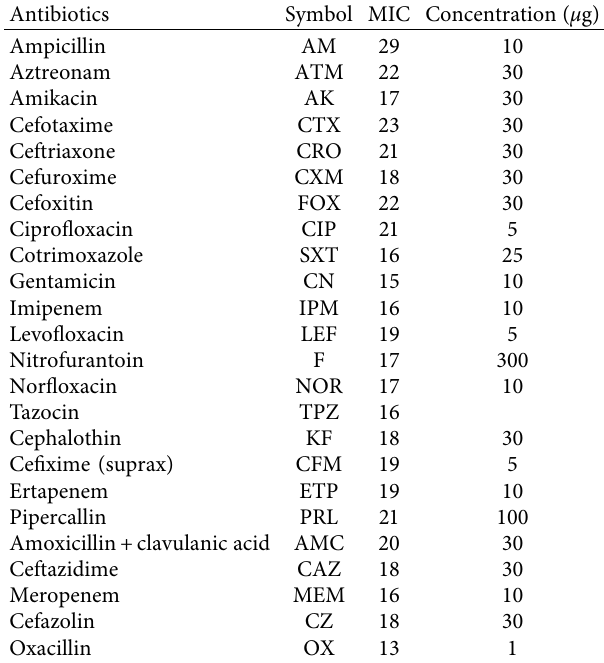
Table 1: S. aureus isolates tested for susceptibility to antibiotics.